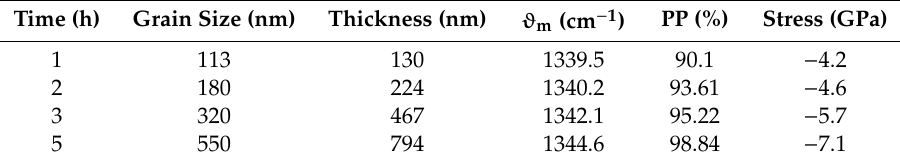
Figure 9. Raman spectra of the diamond films for different growth times. Table 4. Grain size, thickness, Raman peak, phase purity, and stress of diamond for different growth durations.